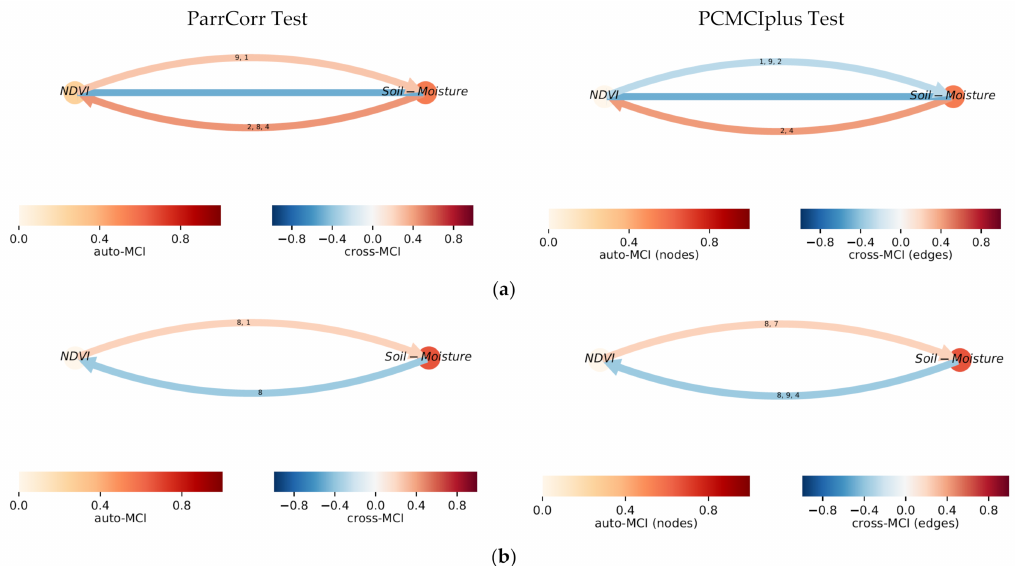
Figure 7. Results of the nonlinear causality between NDVI and SMOS for ( a ) Colombia and ( b ) East Amazon: ParrCorr ( left panels) and PCMCIplus ( right panels). Node colors denote the nonlinear auto-dependency of each variable, whereas colors of the lines denote the cross-MCI between both variables, and the horizontal lines denote the simultaneous nonlinear